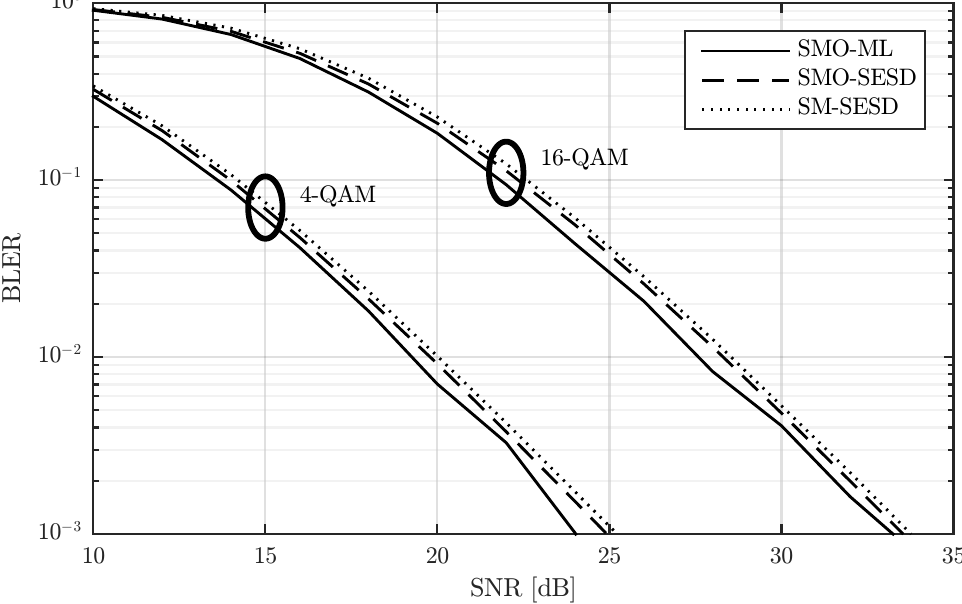
Figure 2. Performance comparison of a PSAM and its element orthonormalization with two different receivers for T = 4, M = N = 2, and two transmission